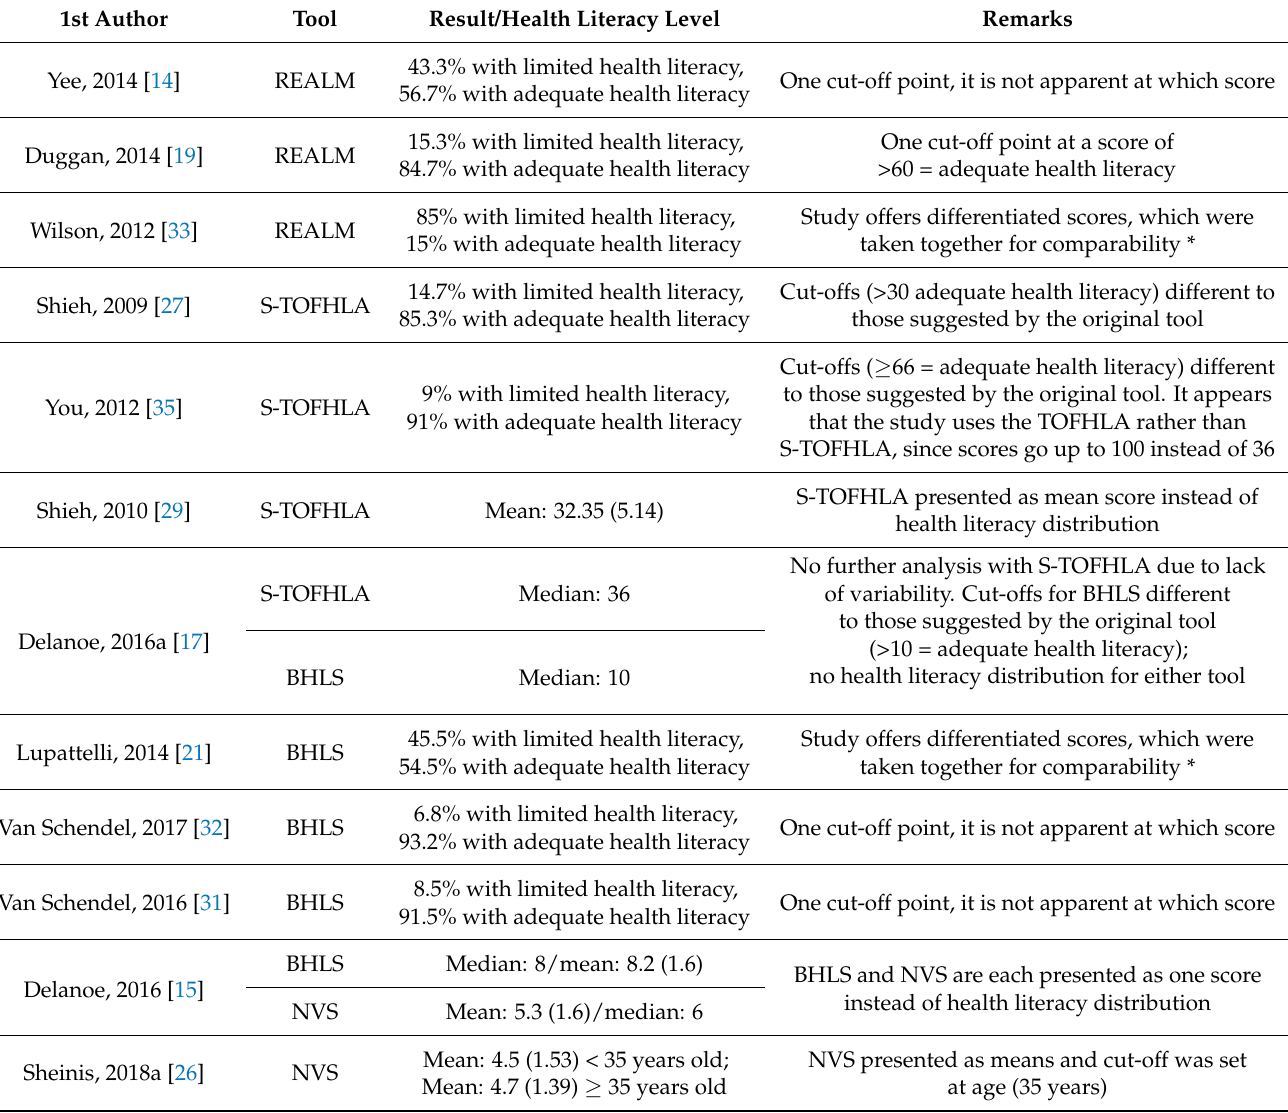
Table 4. Studies that described health literacy levels in pregnant